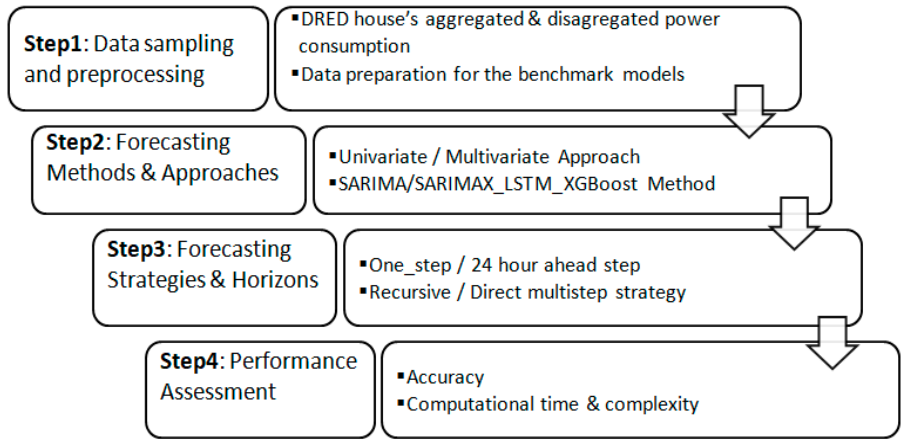
Figure 2. The proposed design and evaluation methodology.